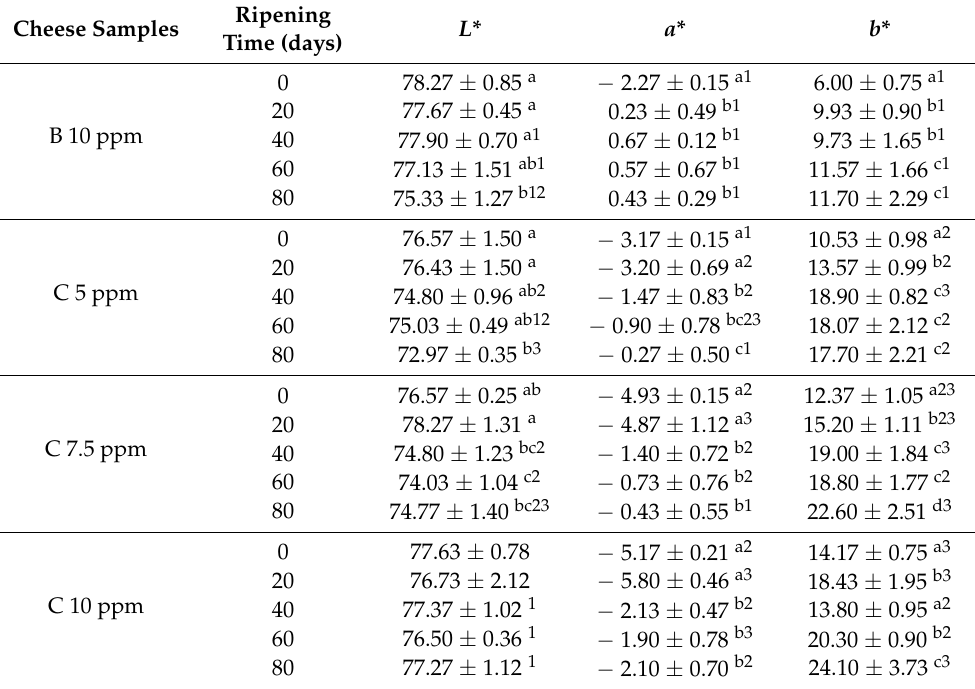
Table 3. Color, in units of L*, a*, and b * in the manchego-style cheeses at different ripening times. Cheese Samples